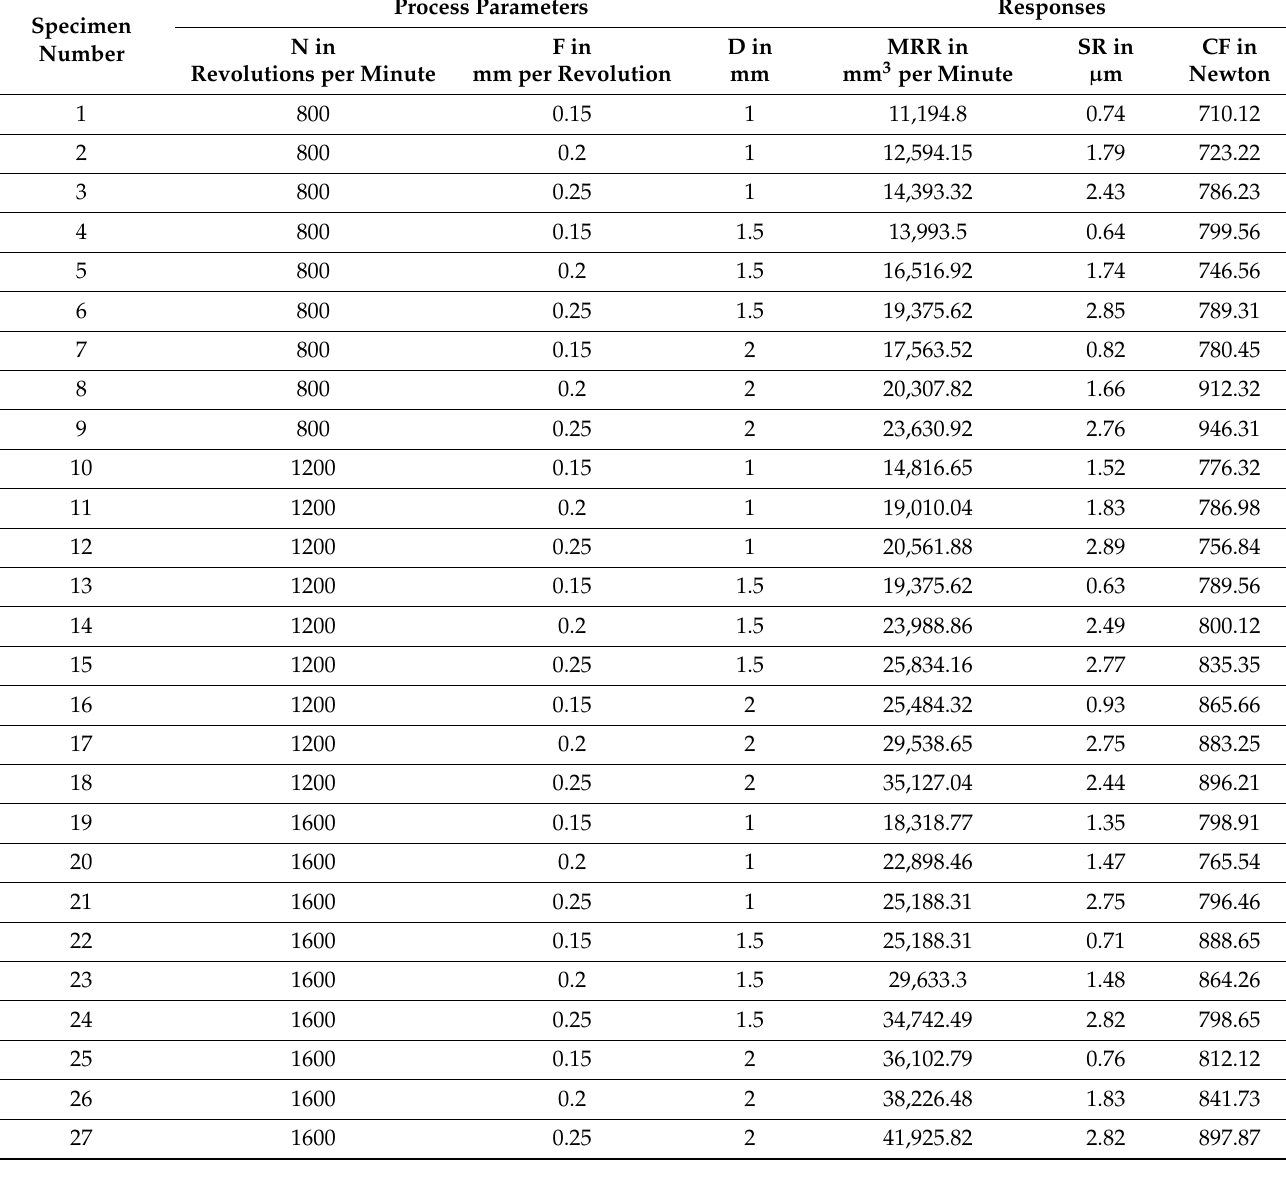
Table 3. L27 orthogonal array with experimental results of responses.